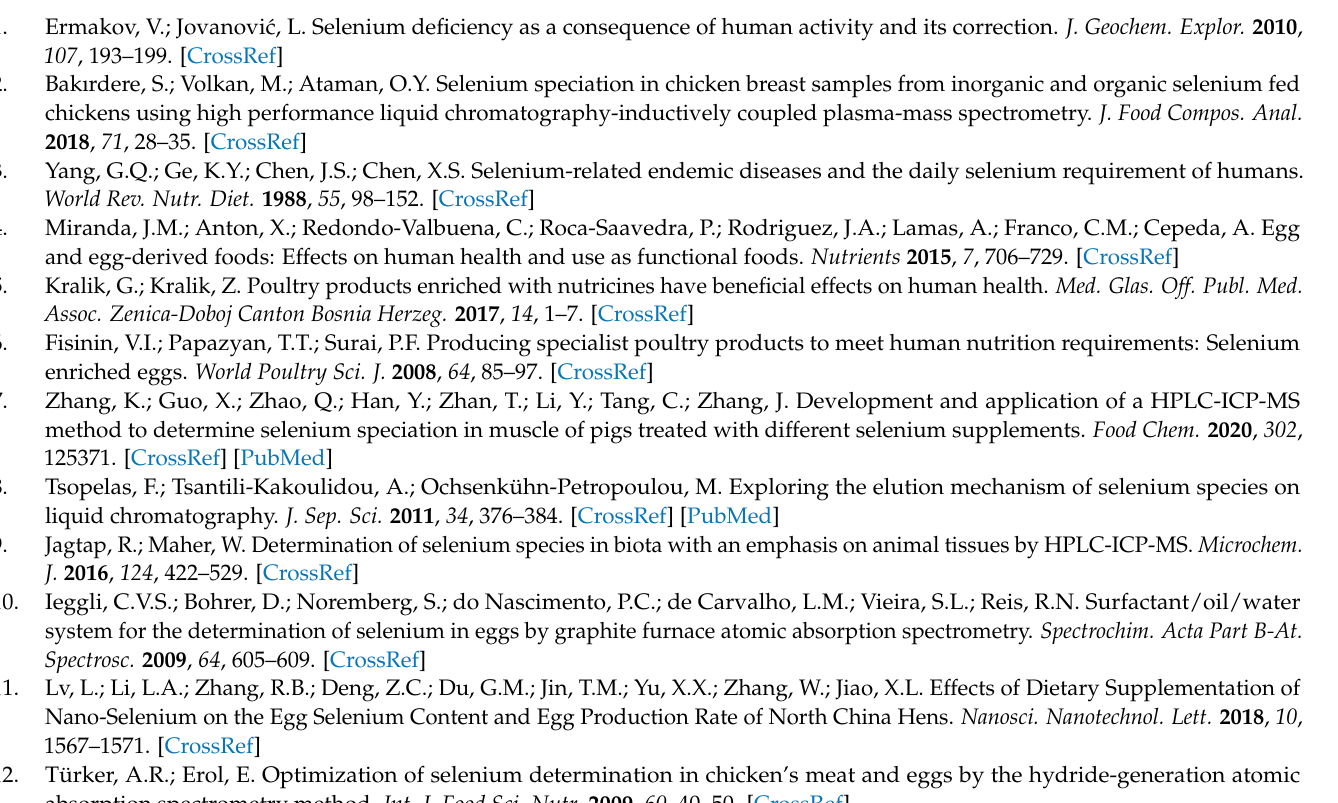
Table S1: Analytical performances of five Se